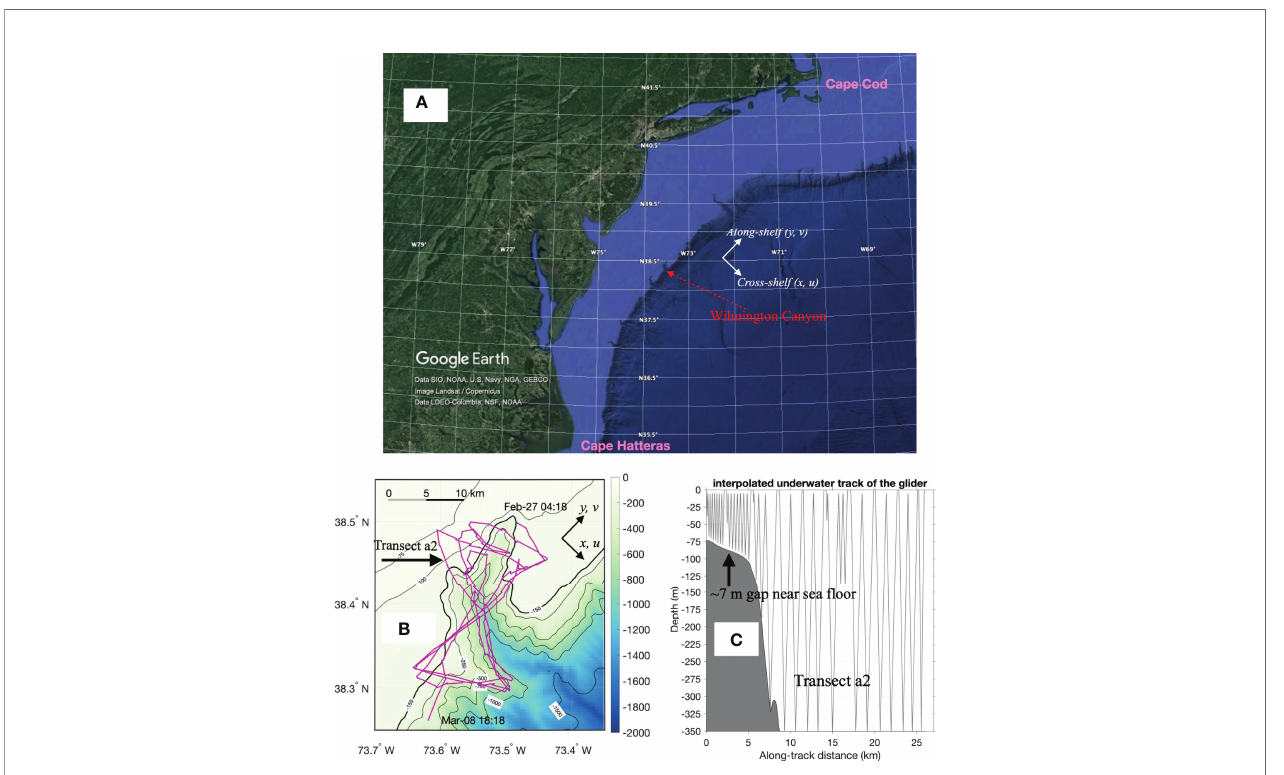
FIGURE 1 | (A) Location of Wilmington Canyon in the Mid-Atlantic Bight. (B) Wilmington Canyon bathymetry with glider survey track (magenta line) during 02/27-03/ 08/2016. (C) Underwater track taken by the glider at transect a2. The glider used in this study has a maximum diving depth of 350 m. At locations shallower than 350 m, the glider ’ s altimeter sensor was used during diving to prevent the glider from hitting the sea fl oor. Thus, the water column within 7 m above the sea fl oor was generally not